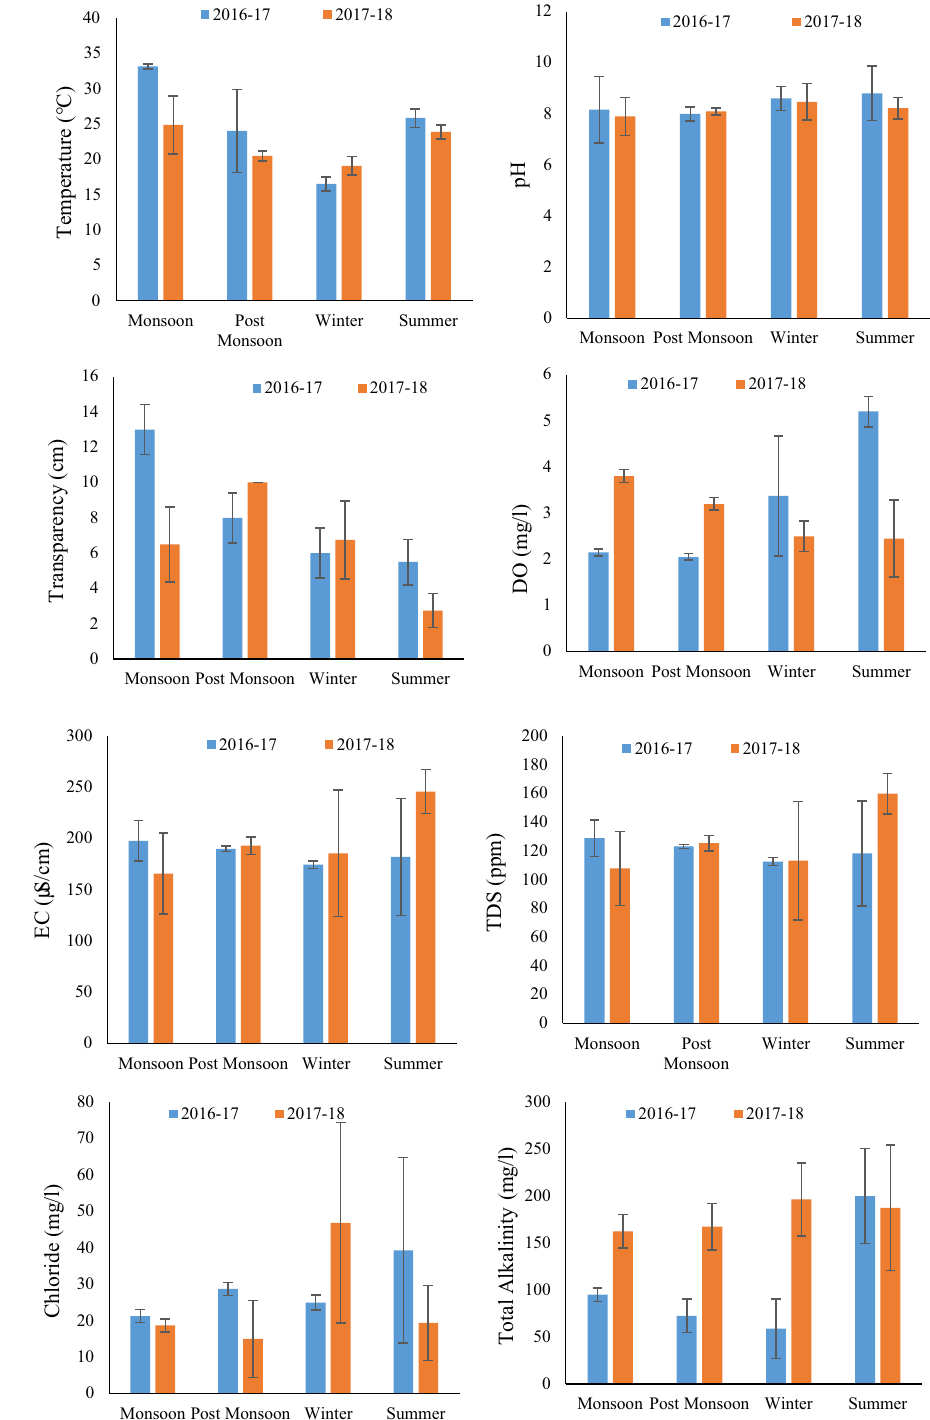
Fig. 2 Graphs showing aver- age and standard deviation of different physico-chemical parameters of water quality during different seasons of both study